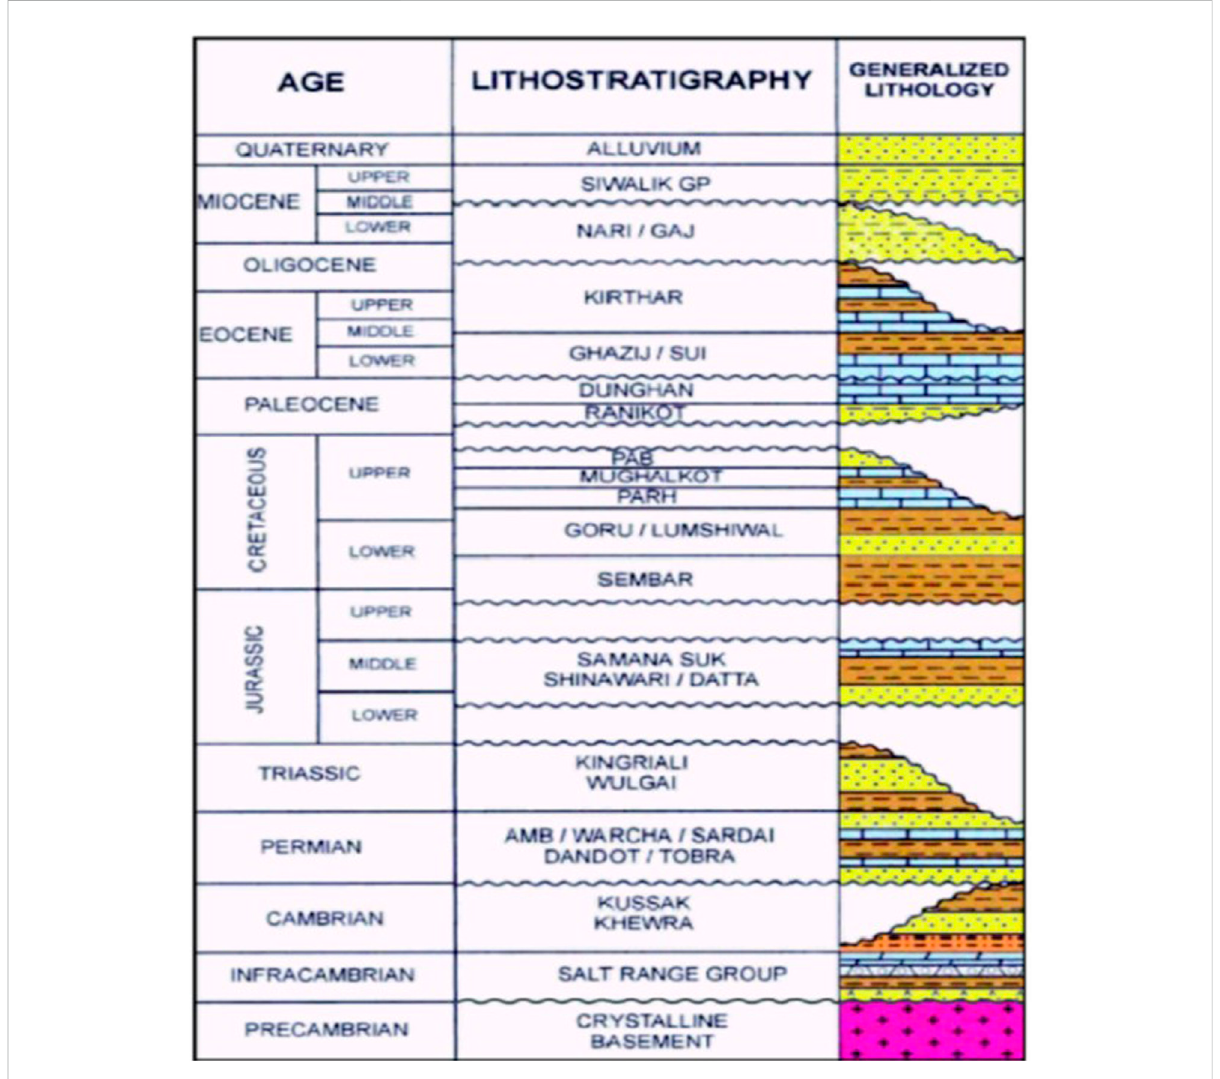
FIGURE 3 Generalized stratigraphic column of the Middle Indus Basin (after Kadri, 1995; Khalid et al.,